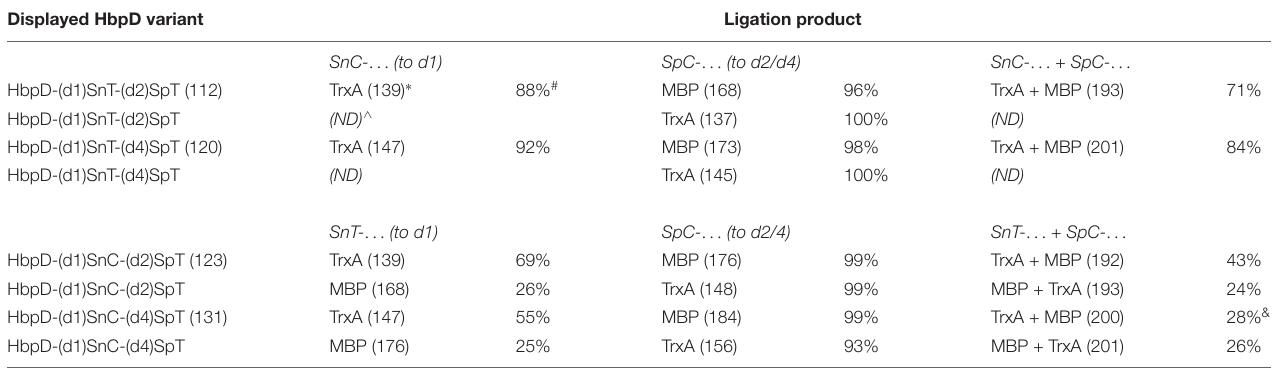
TABLE 3 | Spy- and Snoop-coupling efficiencies to HbpD displayed on OMVs. Displayed HbpD variant